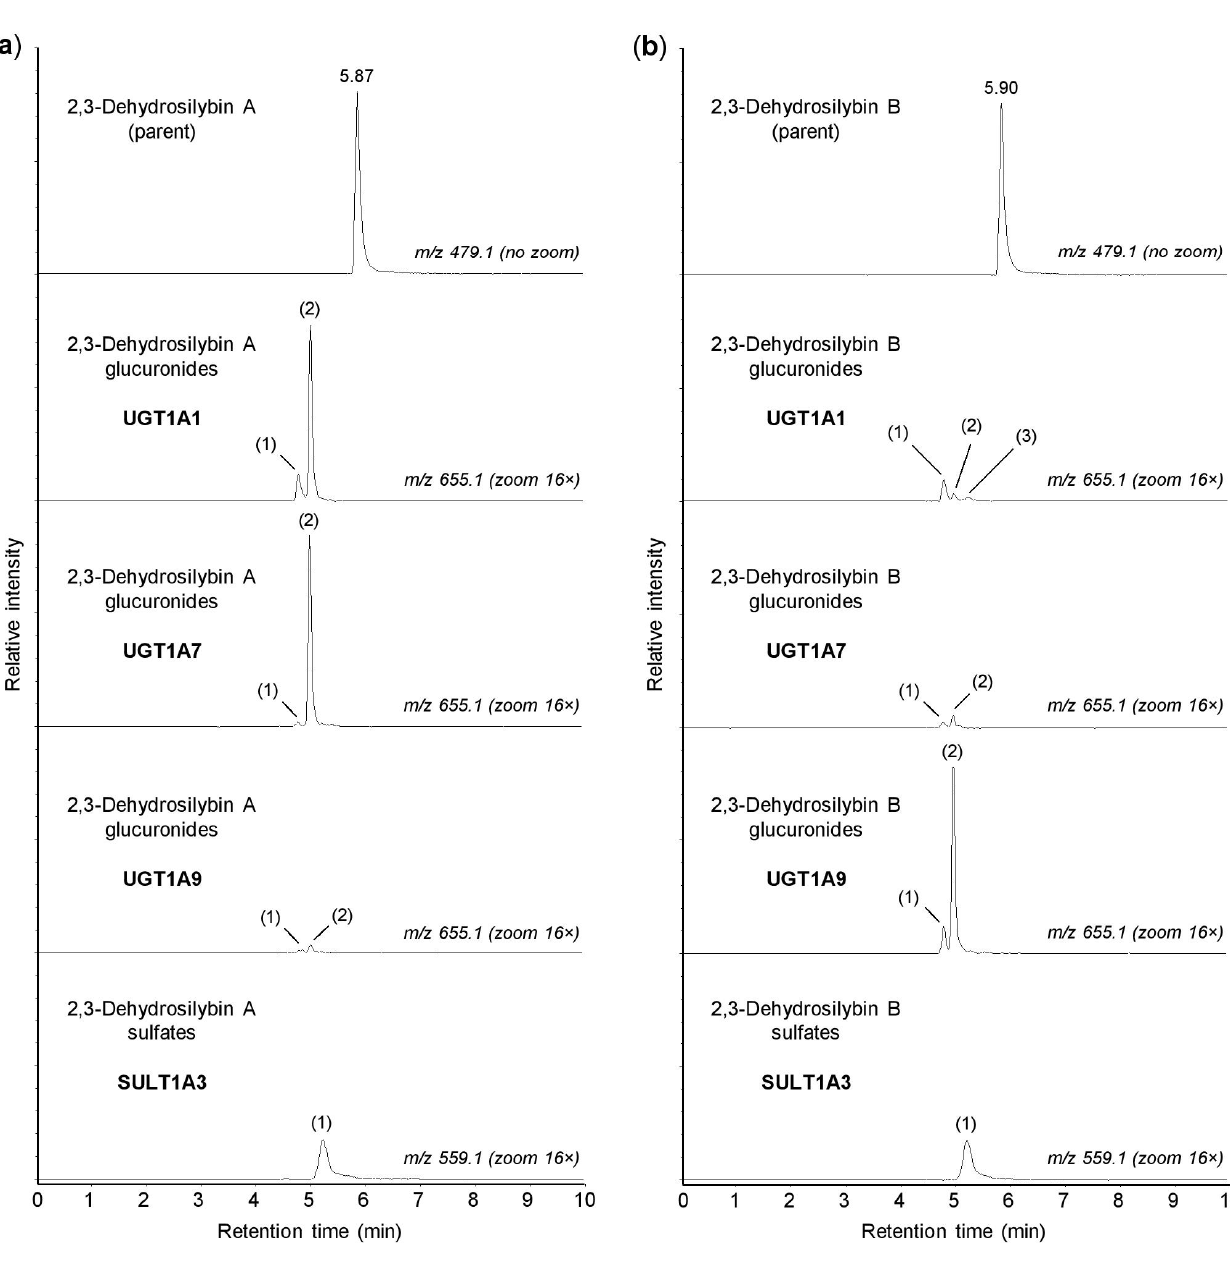
Figure 3. Glucuronidation and sulfation of 2,3-dehydrosilybin A and B by recombinant human enzymes. Human UGT1A1, UGT1A7, UGT1A9, and SULT1A3 were incubated for 30 min with 50 µ M 2,3-dehydrosilybin A (panel a ) or 2,3-dehydrosilybin B (panel b ), and the biotransformation products were analyzed by UHPLC-MS. The peaks of glucuronides and sulfates are marked with numbers (in brackets) corresponding to those in Tables 2 and 3. The signal intensity in chromatograms was adjusted to the same value before using the zoom tool.